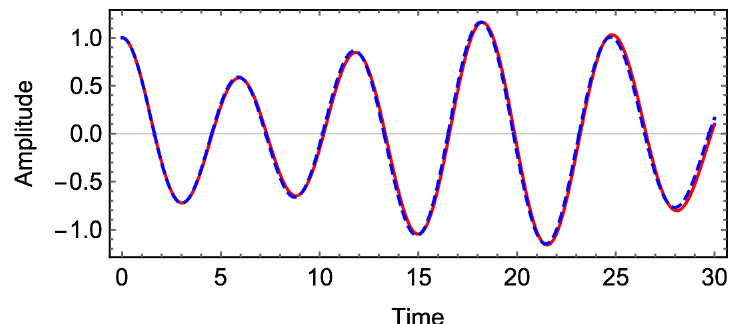
Figure 4. The red curve is the numerical result and the dashed blue curve is the solution by the DTM given in Equation (20).